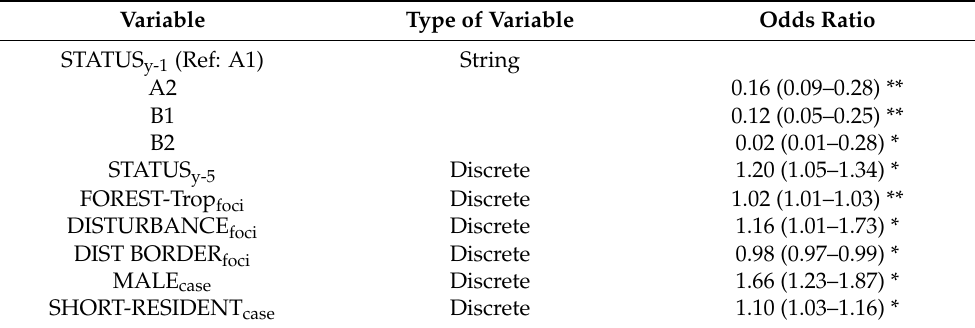
Table 3. Results of the logistic regression performed with the STAR